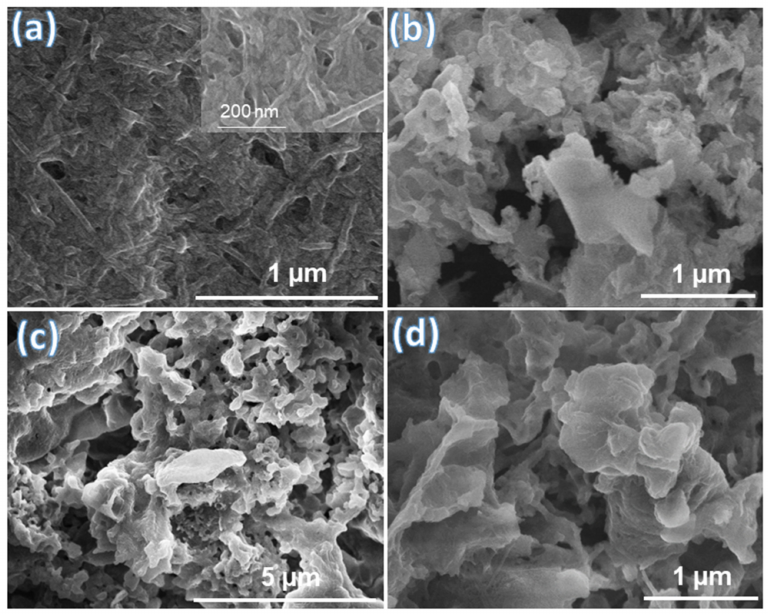
Figure 2. SEM images of ( a ) free-standing porphyrin aggregates, ( b ) g-C 3 N 4 , and ( c , d ) g-C 3 N 4 /porphyrin